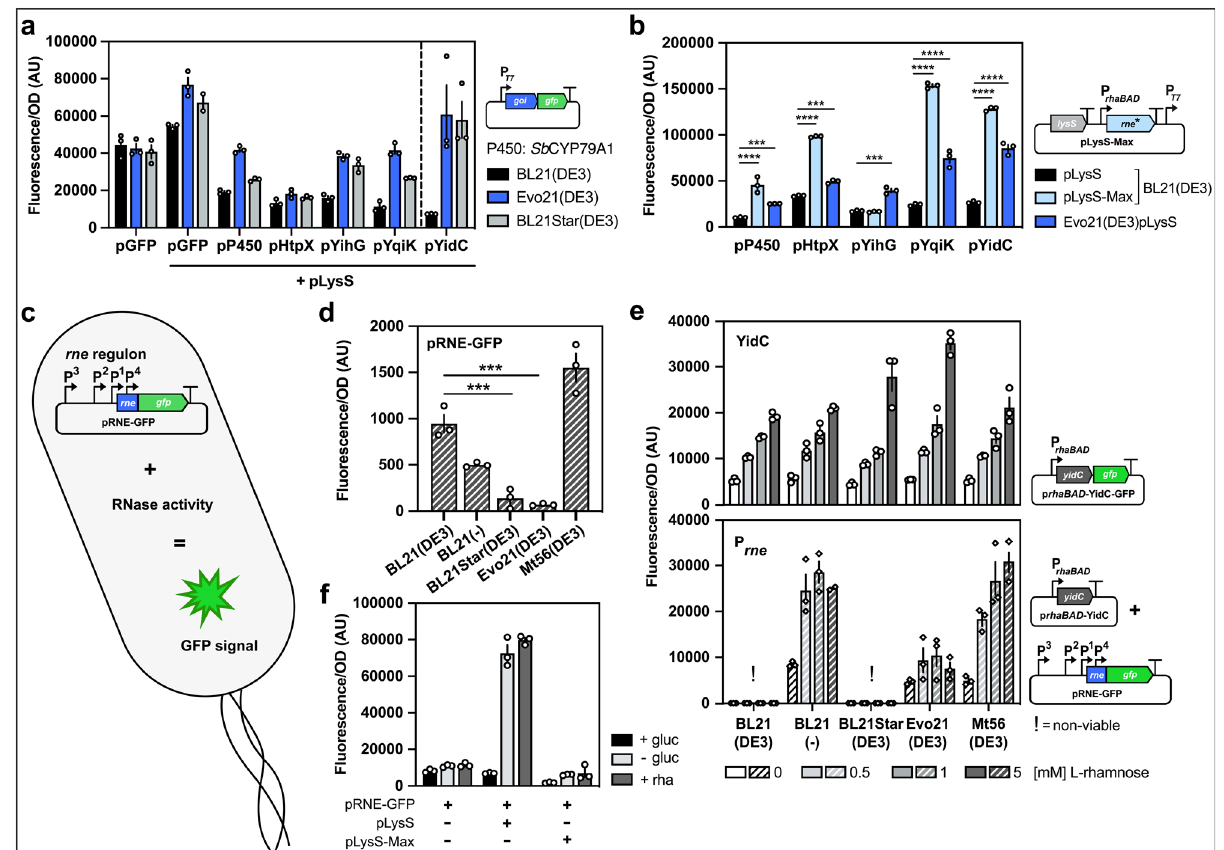
Fig. 4 Effect of rne mutations on protein production and RNase activity levels in E. coli . a Heterologous production of a variety of non-toxic and toxic GFP-fusion proteins in Evo21(DE3) and BL21Star(DE3), both harbouring different truncations of the rne gene, compared to BL21(DE3). b Expression of the same genes in Evo21(DE3) is compared to expression in BL21(DE3) when co-expressing either the auxiliary plasmid pLysS or pLysS-Max. c Schematic illustration of the plasmid pRNE-GFP designed to report on RNase activity. Promoters controlling rne expression are indicated (P1 – 4) 49,50 . The expression level of the rne gene can be monitored in vivo via GFP fl uorescence signal. d Exploration of the pRNE-GFP reporter plasmid in BL21(DE3) derivatives. Different levels of RNase activity can be monitored in the strains. e Titration of yidC expression in Evo21(DE3), BL21Star(DE3) and BL21(DE3) via increasing levels of L -rhamnose and its effect on the rne regulon expression reporting RNase activation in the cell during toxic membrane protein production. Upper half: Fluorescence corresponds to YidC-GFP production levels. Lower half: Cells harbour both the rne reporter plasmid (pRNE-GFP) and pP rhaBAD -YidC controlling yidC expression (no GFP fusion). Fluorescence levels correspond to GFP produced under the control of the rne regulon. f Effect of the pLyS-Max auxiliary plasmid on RNase activity. Plasmids pLysS and pLysS-Max are co-expressed along with pRNE-GFP in BL21(DE3) cells. To repress leaky expression of the rhamnose promoter controlling rne* expression on pLysS-Max, 0.4% glucose was added where indicated. Error bars indicated represent the average squared deviation from the mean (SD) of three biologically independent samples ( n =